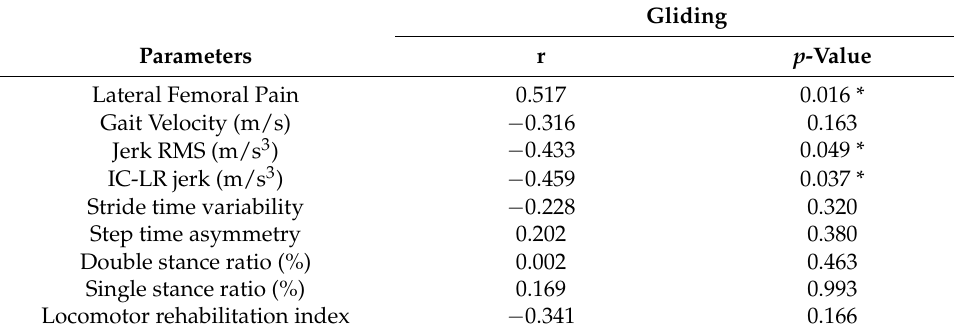
Table 2. Correlation between gliding and each gait parameter.